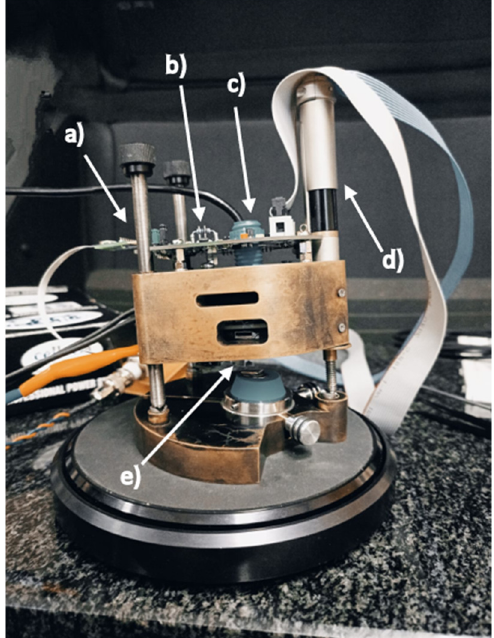
Figure 4. Atomic force microscope head operating with an active piezoresistive cantilever used to study the wear properties of the model prosthetic dentures. (a) Micrometer screw adjusting the height over the investigated sample; (b) signal preamplifier; (c) endoscopic camera holder; (d) DC motor for tip-surface coarse approach; and (e) Cantilever holder.